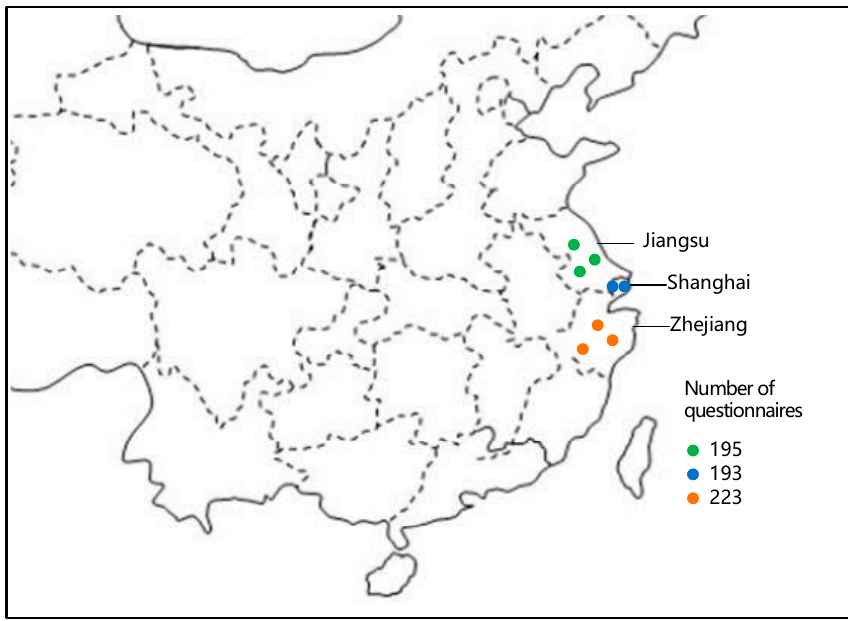
Figure 1. The geographical distribution of the questionnaires.